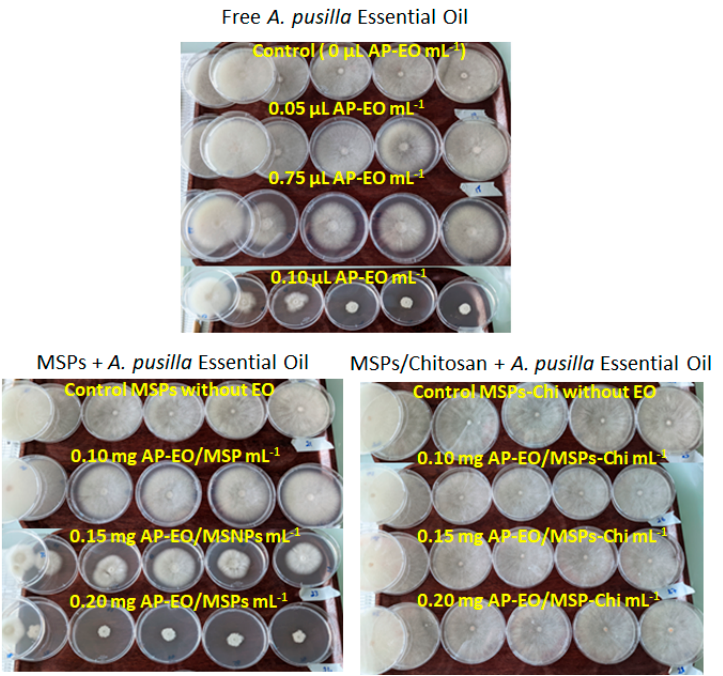
Figure 8. Effects of MSPs and AP-EO introduced in the culture medium on the mycelial growth of F. avenaceum incubated for 10 days at 25 ◦